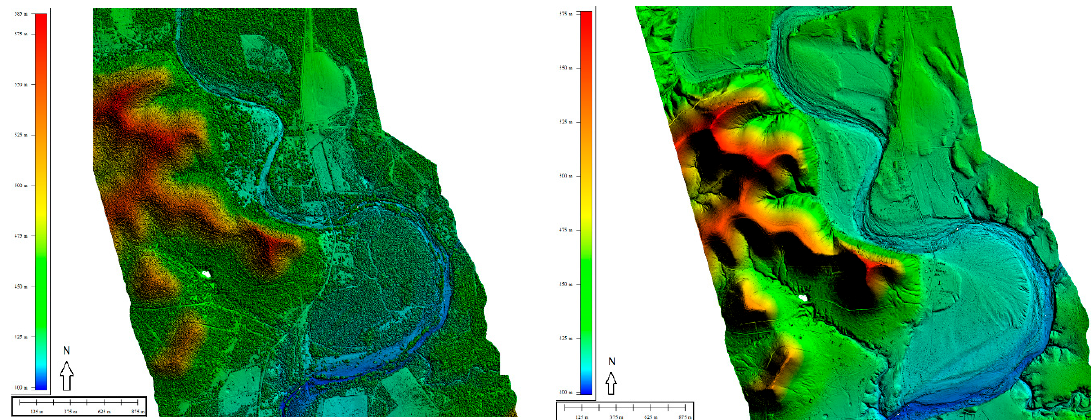
Figure 11. Slant-range adjustment of Chiroptera scanners; control points versus Lidar-derived patch elevation-lagged residuals. Residuals do not indicate any underlying patterns, but only a few outlier measurements.